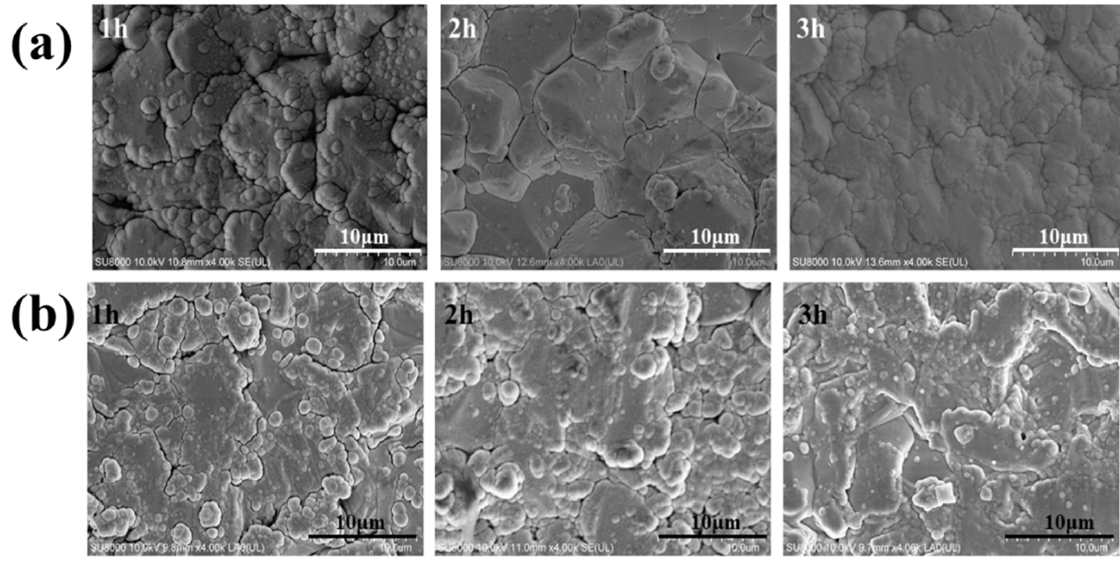
Figure 6. SEM images of thin films ( a ) Cu-250 °C and ( b ) CuNi-250 °C at different heat treatment times.